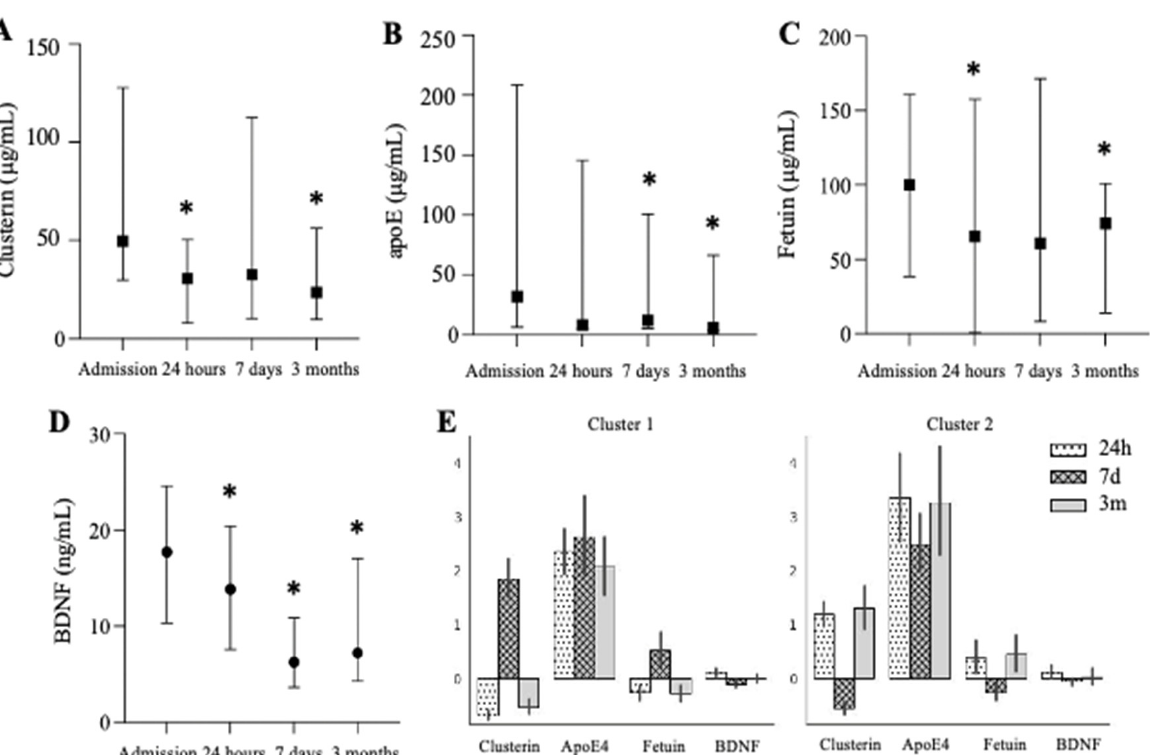
Figure 4. Temporal dynamics of neuroprotective markers after cardiac surgery. Levels of clusterin ( A ), apoE ( B ), fetuin ( C ), and BDNF ( D ) at baseline, 24 h, 7 days, and 3 months post-surgery. Two clusters of neuroprotective data were identified across studied patients ( E ). * denotes p < 0.05 as compared to admission value